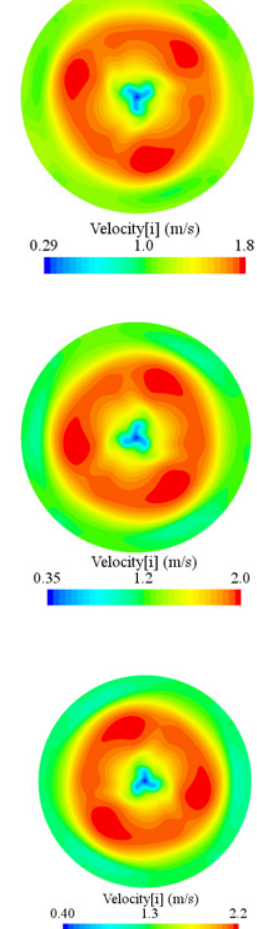
0.085 D a downstream of the rear propeller disk.